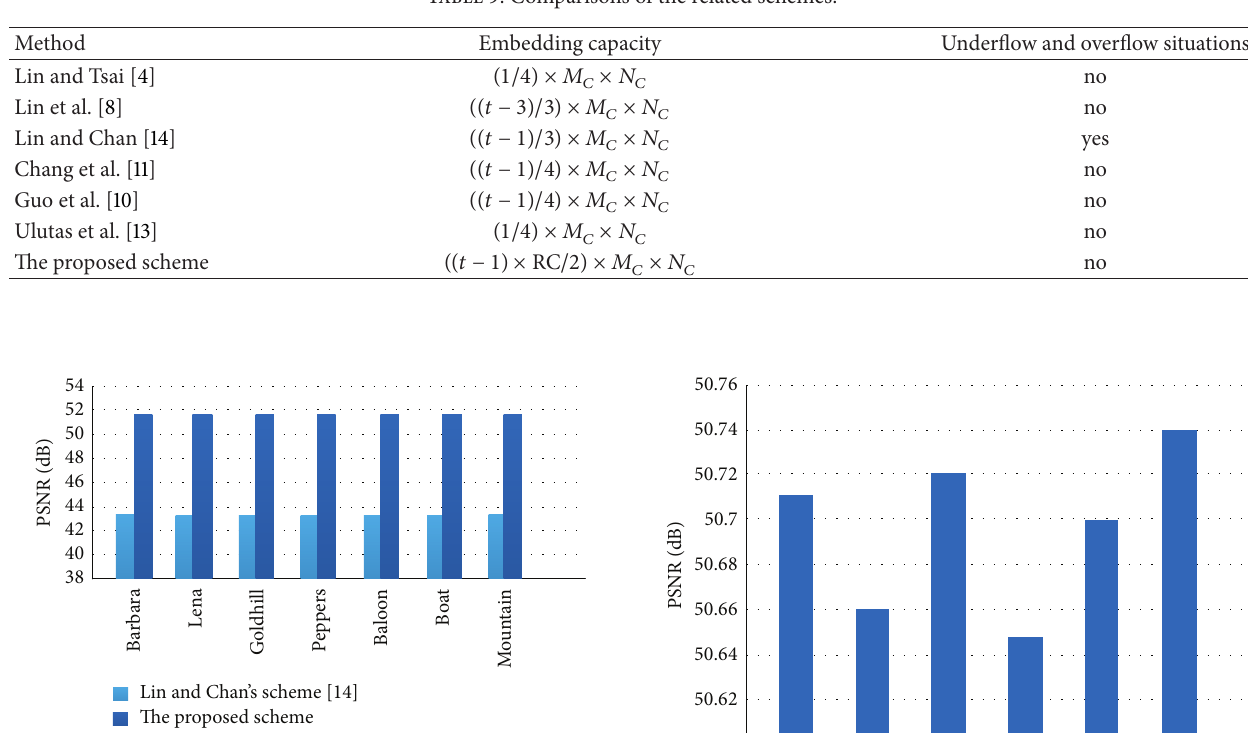
Figure 12: PSNR of two schemes for different grayscale cover images.